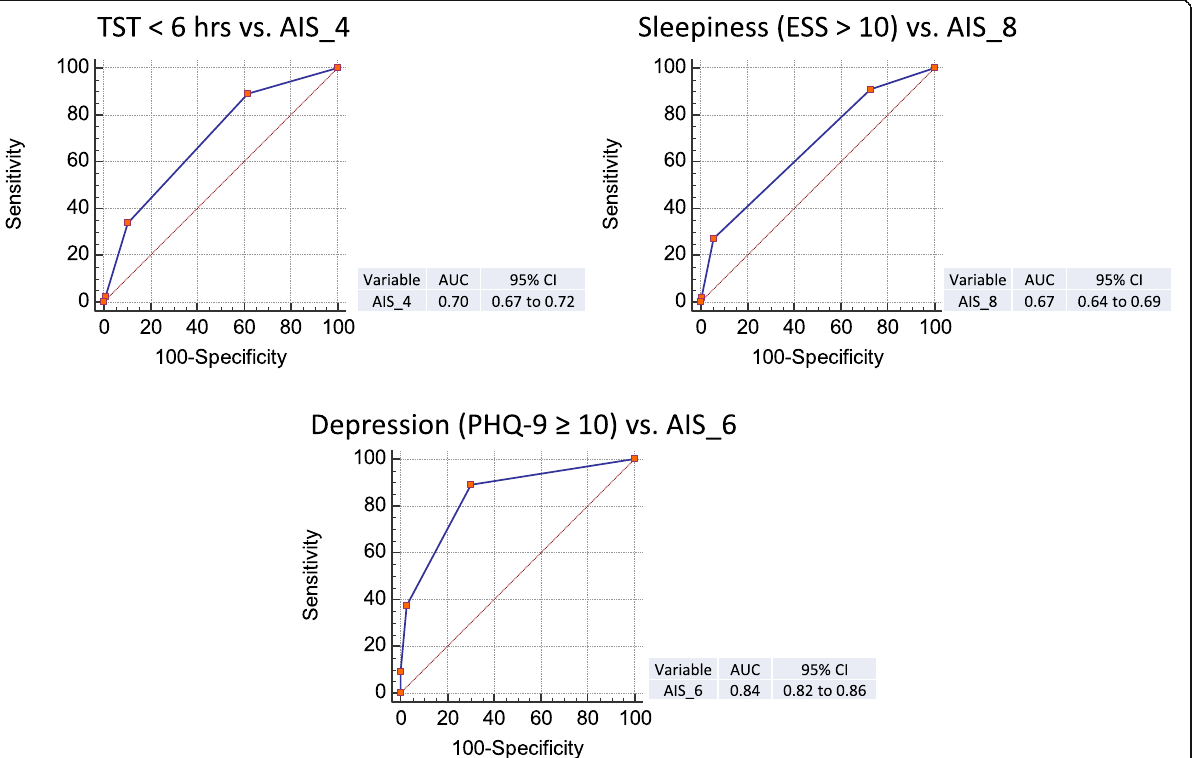
Fig. 4 Receiver operating characteristic (ROC) analysis of the Athens Insomnia Scale (AIS) item scores for the comparison of short sleep duration and sleepiness. AIS_4, fourth AIS item: total sleep duration; AIS_6, sixth AIS item: problems with sense of well-being; AIS_8, eighth AIS item: sleepiness during the